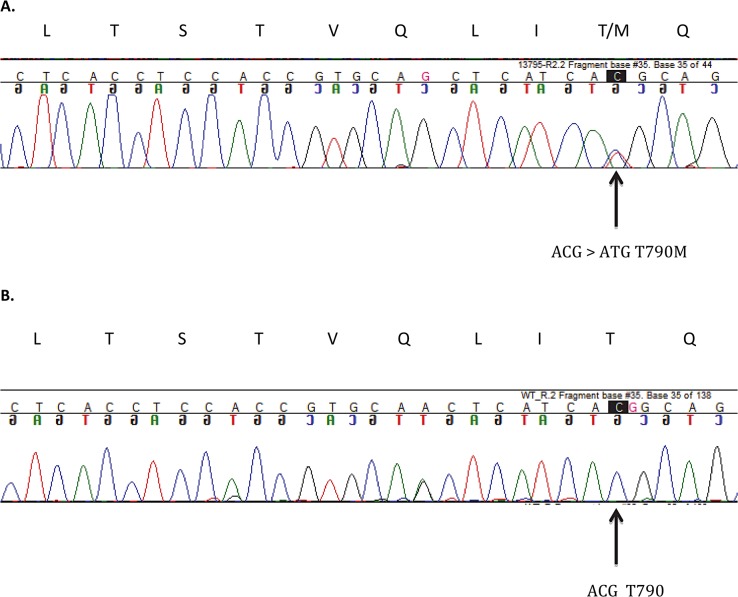
Sanger sequencing.Sanger sequencing of the EGFR point mutation in a positive breast cancer sample (A) compared to wild-type control (B). The peak of the mutated allele (ACG > ATG) is indicated by arrow. The upper panel indicates parts of the amino acid sequence encoded by EGFR exon 20.